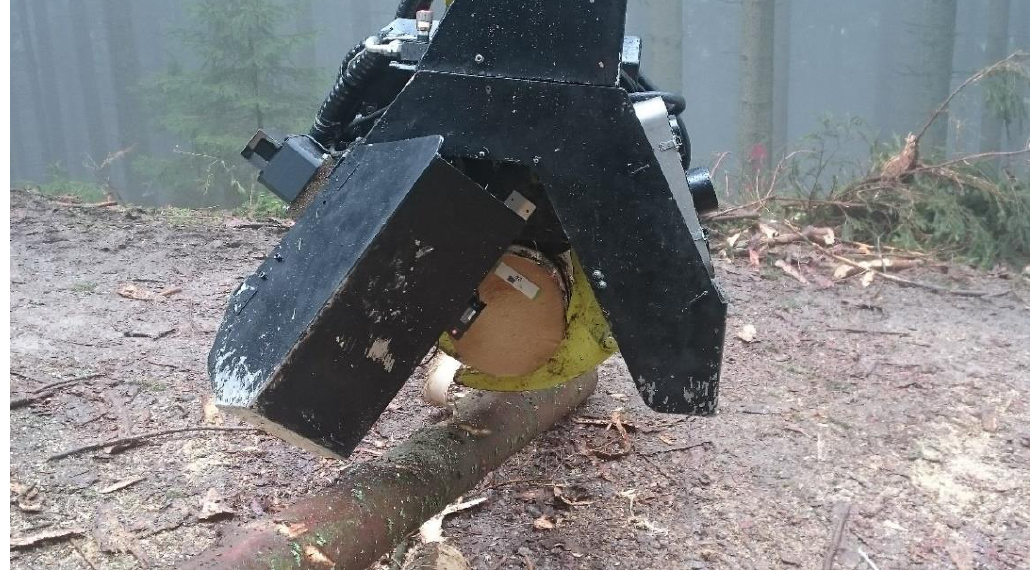
Figure 6. Stapling a new RFID tag (white) on the butt end of the log by an intelligent processor head.